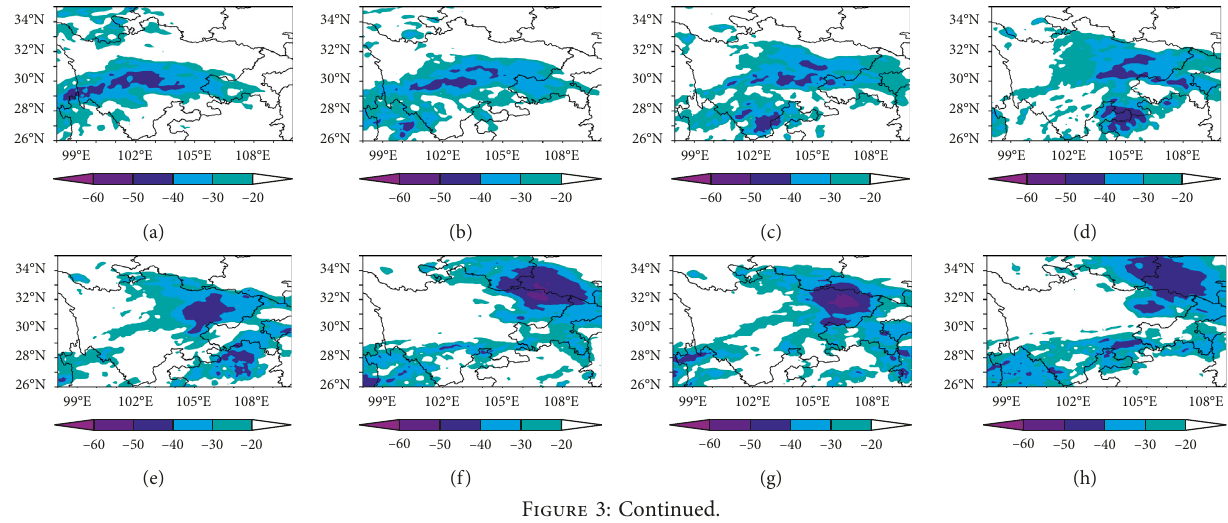
1 ; LLJ: 1 ), and Tb s 12m s · · − − ≥